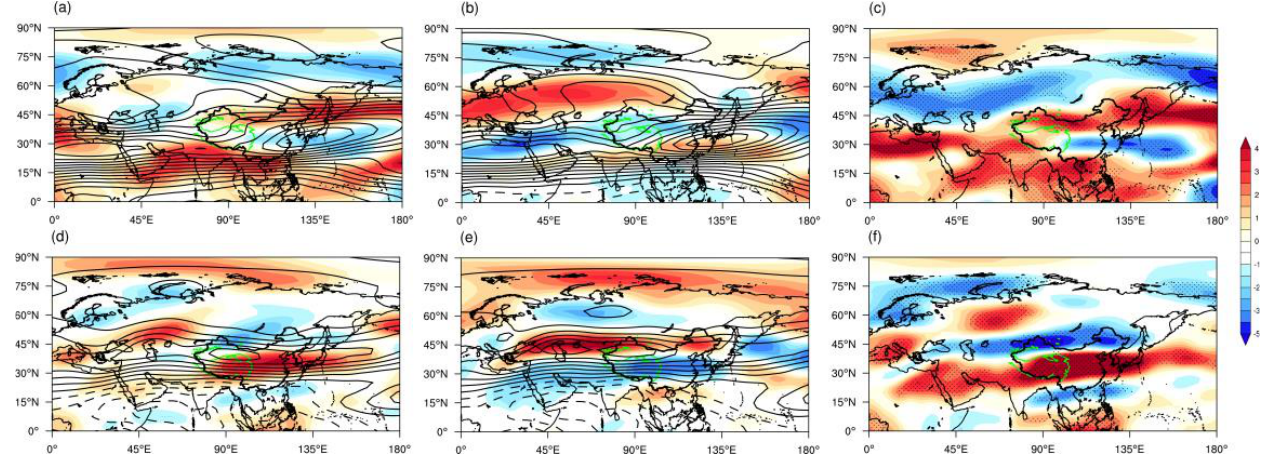
Figure 9. Composite anomalies in 200 hPa zonal winds in high (left column) and low (middle col- umn) spring snowmelt years and the differences between high and low spring snowmelt years (right column): ( a – c ) spring; ( d – f ) summer. The markers represent grid point values that were significant at the 90% level. Green line outline the areas of the TP with an average altitude greater than 3000 m.